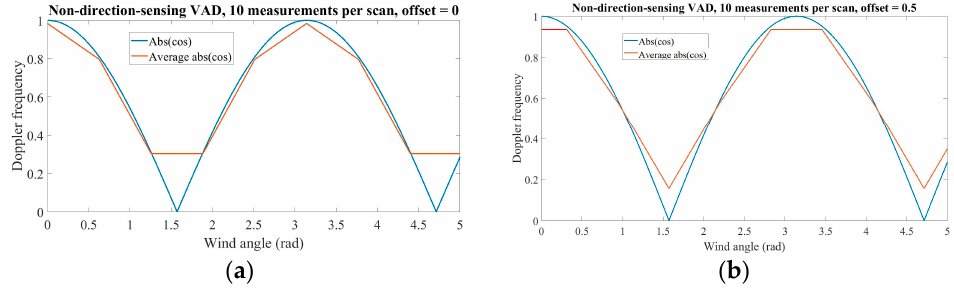
Figure 11. Rectified cosine function and its time-windowed average, representing the Doppler-estimating behaviour of a non-direction-sensing lidar; compare this with the typical ZephIR display in Figure 10a. For each scan rotation, the average of the cosine is obtained for each of 10 contiguous segments (arcs) of π /5 radians. ( a ) The true wind heading coincides with the midpoint angle of a segment (i.e., zero offset); ( b ) The true wind angle coincides with the edge of a segment (i.e., offset = 0.5 segment).